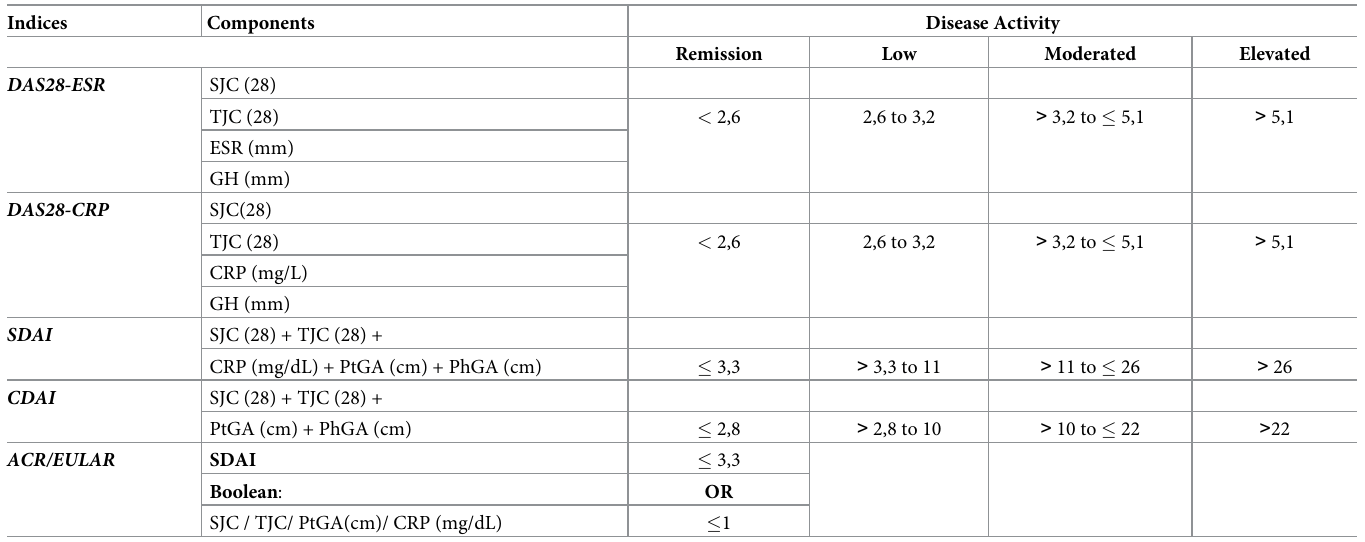
Table 1. Composite disease activity indices and classifications [9, 11, 30, 31].